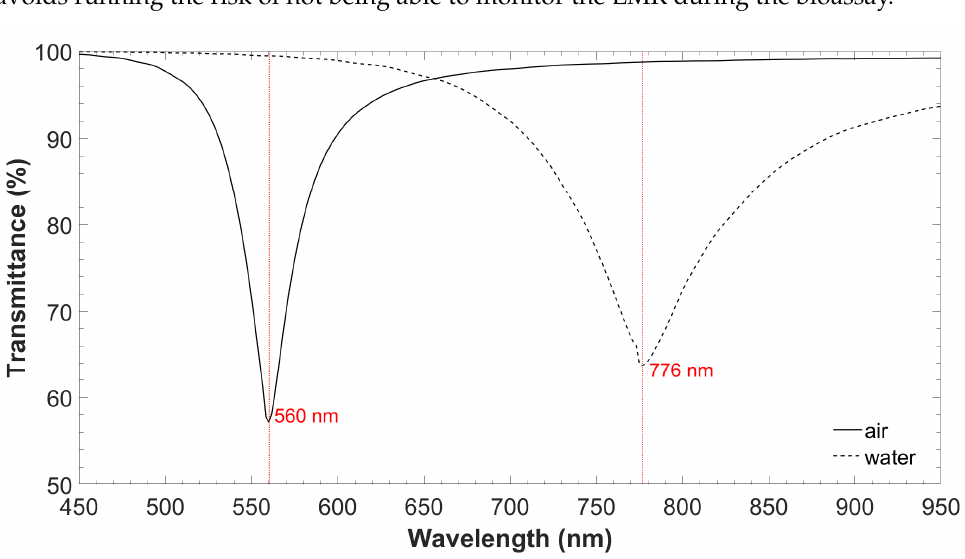
Figure 2. Theoretical optical spectrum in the air and water of the generated LMR by the ALD technique with TiO 2 thin film on the coverslip.